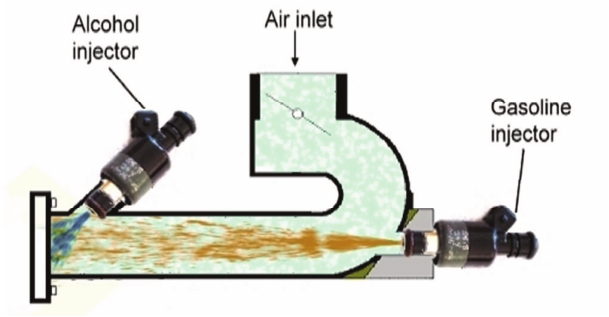
Fig. 1. Scheme of prototype inlet manifold of Fiat 1100 MPI engine